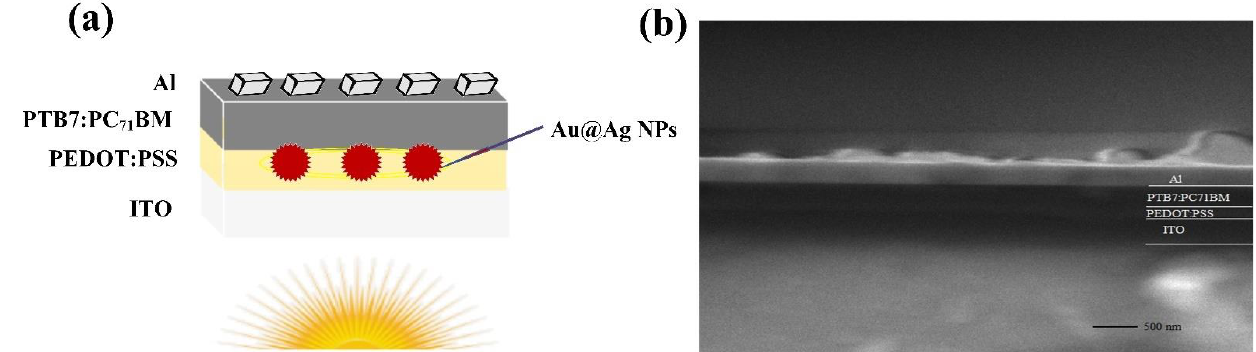
Figure 1. ( a ) Schematic of the OSC and ( b ) FESEM cross-section of the